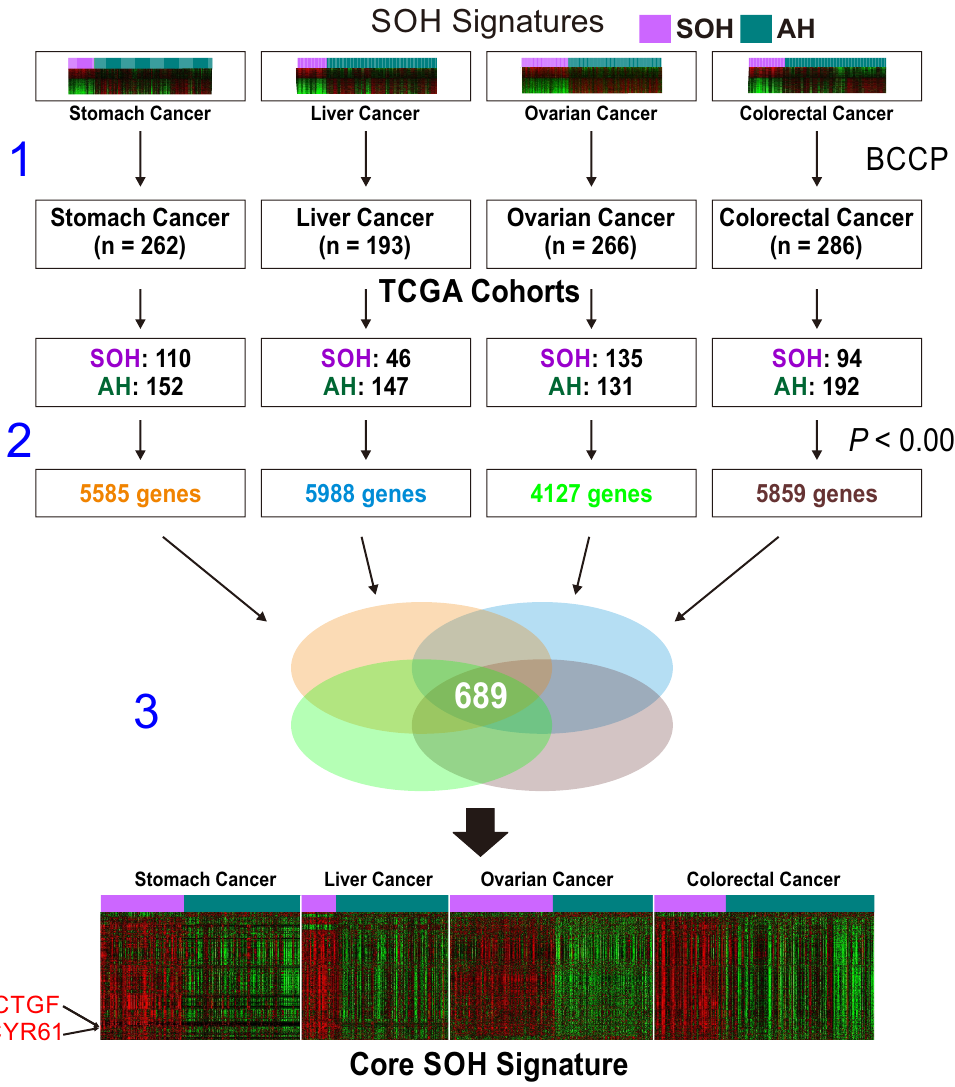
Figure 1. Schematic overview of the workflow for generation of the core silence of Hippo (SOH) gene expression signature. Step 1: original SOH gene expression signatures from each cancer type were applied to corresponding gene expression data from The Cancer Genome Atlas (TCGA) using the Bayesian covariate compound predictor (BCCP) algorithm. Tumors in TCGA were stratified into SOH or AH (active Hippo pathway) subgroups according to the corresponding SOH signature from each cancer type. Step 2: di ff erentially expressed genes between the SOH and AH subgroups in each cancer type were identified by t -test ( p < 0.001). Step 3: genes common to all four cancers were selected for the core SOH signature (689